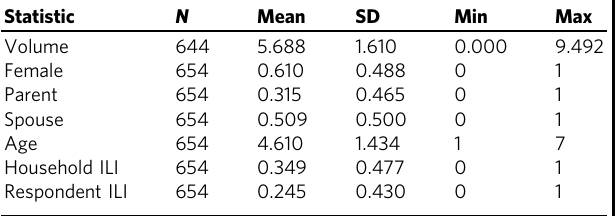
Table 1 Descriptive statistics of survey